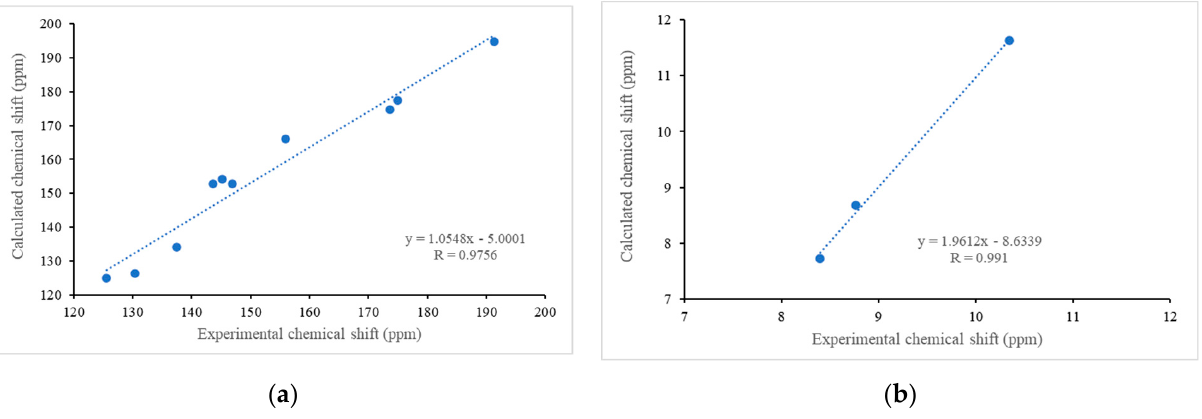
Figure 2. The linear regression between the experimental and calculated ( a ) 13 C NMR; ( b ) 1 H NMR chemical shift of compound 3 .